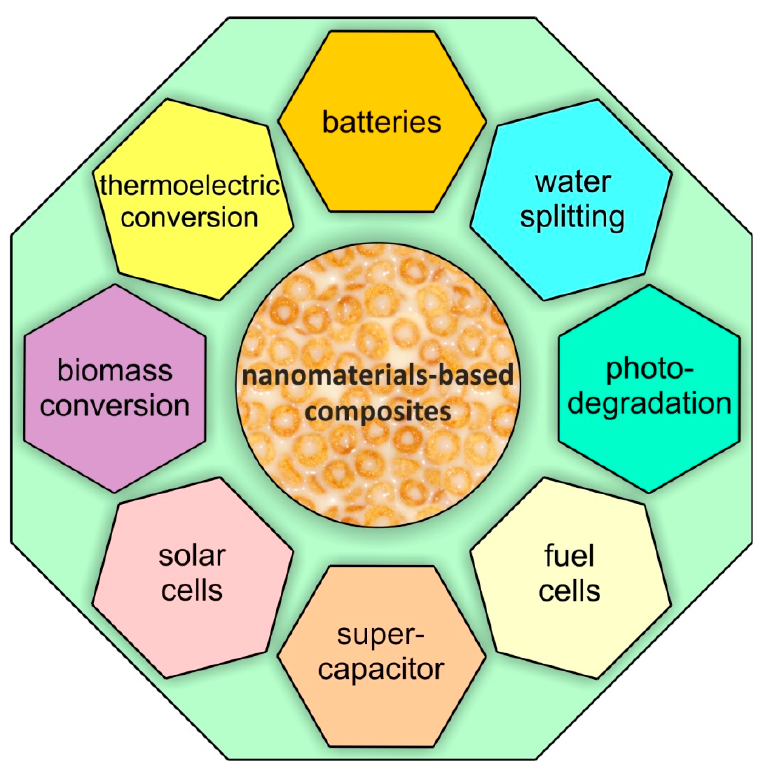
Figure 3. Applications of conducting polymers. Composites with a non-metallic matrix are divided into a polymer (polymer matrix composites—PMCs) and ceramic (ceramic matrix composites—CMCs) [30]. PMCs